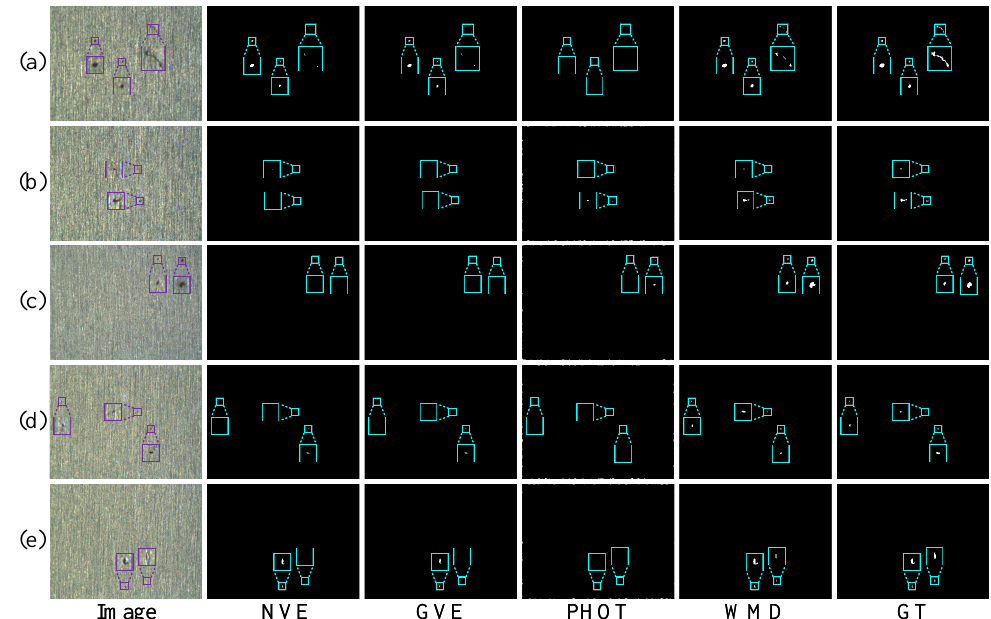
Figure 11. Visual comparisons of four methods on ( a – e ) five randomly selected multiple-defect images. The detection result of the proposed WMD method is quite close to ground truth (GT), whereas the other competing methods are unable to either identify the defect location or completely separate the defect from the